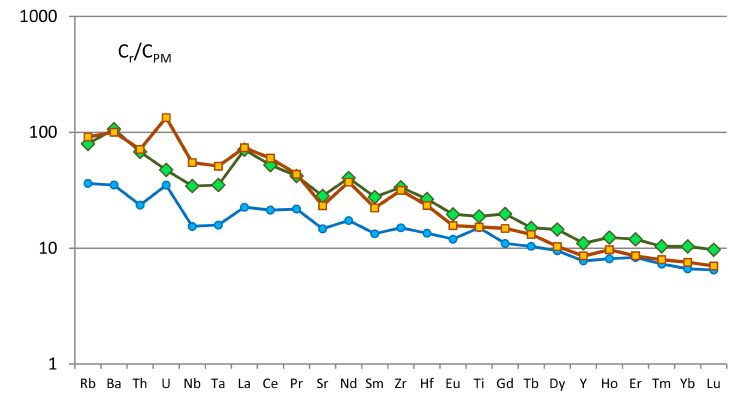
Figure 19. Normalized [19] trace-element patterns for sub-alkaline rocks of Avamsky (blue circles) and Ergalakh complexes of the Norilsk region (yellow squares, SG-9-2200 [16]) and the Turumakit area (green diamonds).